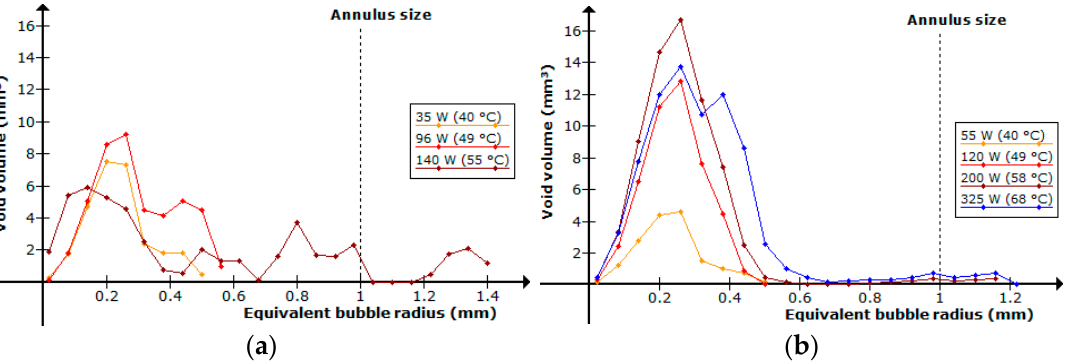
Figure 9. Void volume present in the test section. Measured at refrigerant mass flux ( a ) 150 kg/m 2 s and ( b) 300 kg/m 2 s.